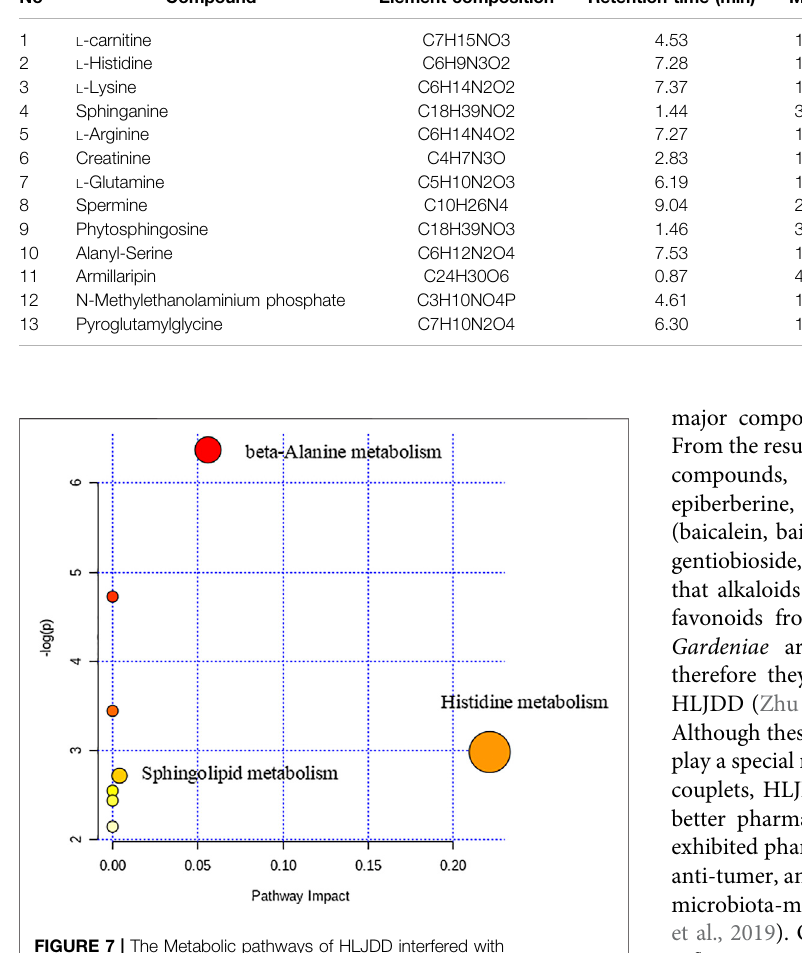
FIGURE 7 | The Metabolic pathways of HLJDD interfered with “ Shanghuo ”